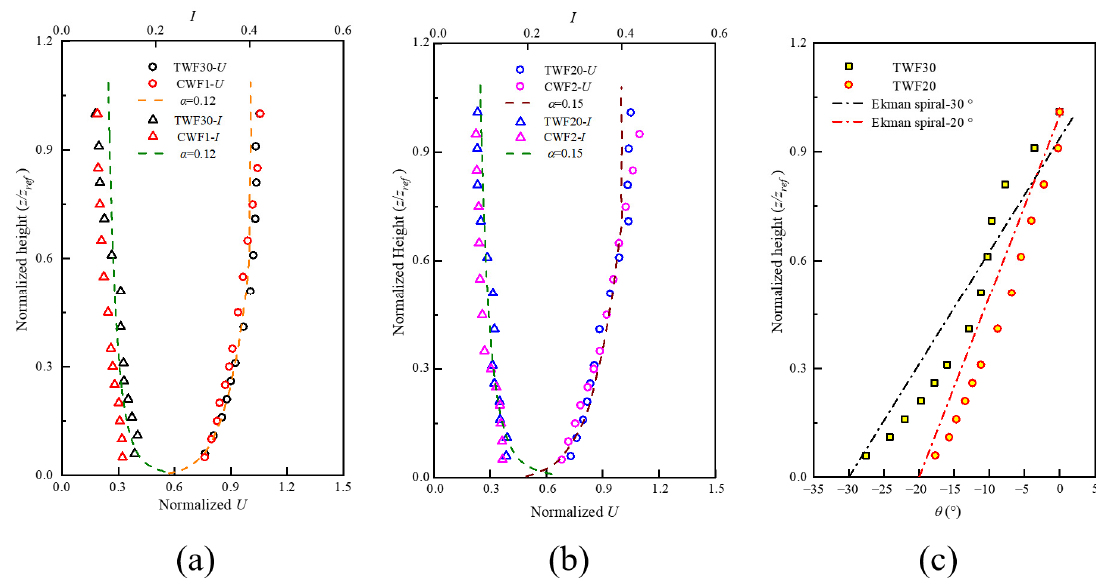
Figure 2. Wind profiles generated in wind tunnel tests: ( a ) Wind speed and turbulence intensity profiles of TWF30 and CWF1; ( b ) Wind speed and turbulence intensity profiles of TWF20 and CWF2; ( c ) Mean wind direction profiles of TWF30 and TWF20.